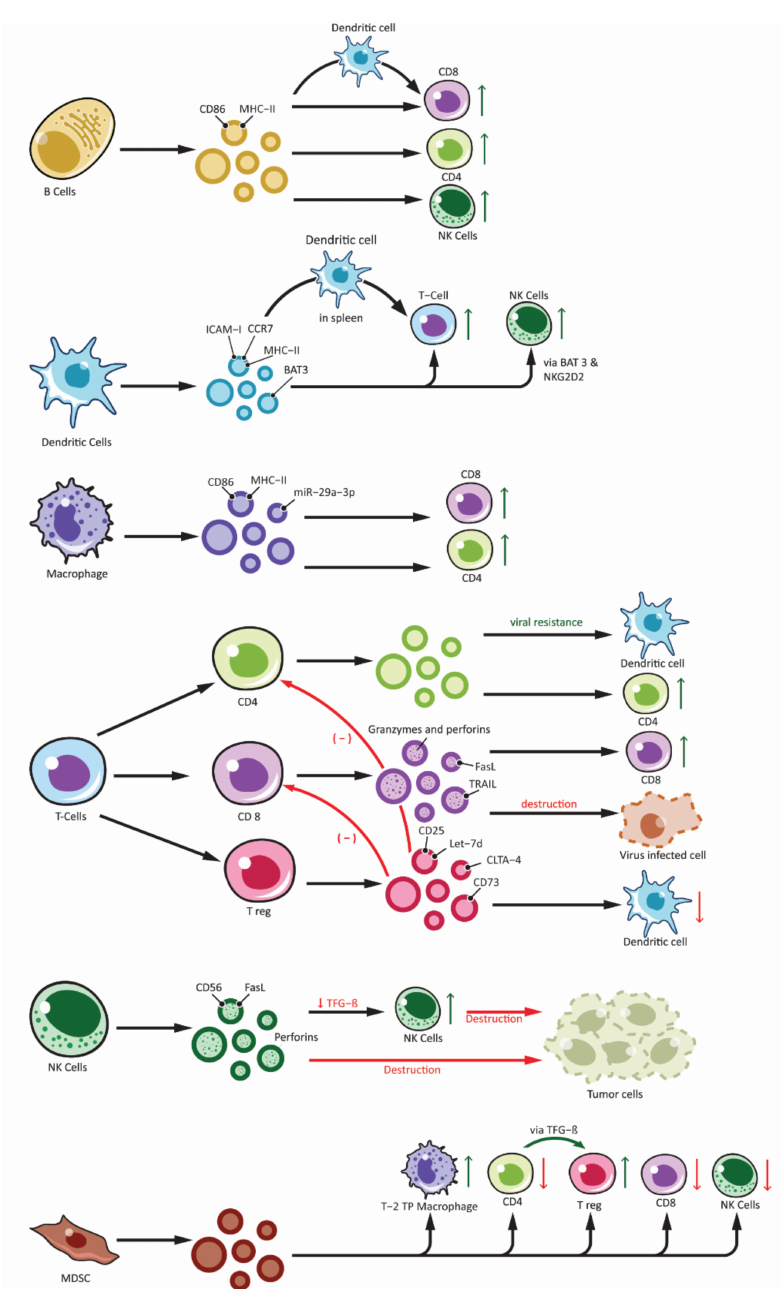
Figure 2. Effects of immune cell-derived exosomes on cellular components of immune system. Showing exosomes produced from various immune cells: B-lymphocytes (B cells), T-lymphocytes (T Cells along with subdivisions of CD4+, CD8+ and Treg), Natural Killer cells (NK-cells), Dendritic cells and other antigen presenting cells (APCs) and Myeloid Derived Suppressor Cells (MDSC). Immune cell derived exosomes can affect various other cells participating in the immune responses. Exosomes can stimulate immune response by: peptide-MHC complex presentation to T cells, antigen transfer to other dendritic cells, activation of T cells, B cells and NK cells. Similarly, inhibitory function is derived from exosomes from Treg and NK cells and this include overall inhibition of the adaptive arm of immune response as well as destruction of tumor cells by NK cell. Exosomes from MDSC also plays an important role in immune inhibition mainly by activating Treg and Type-2 Tumor promoting phenotype macrophages (T-2 TP